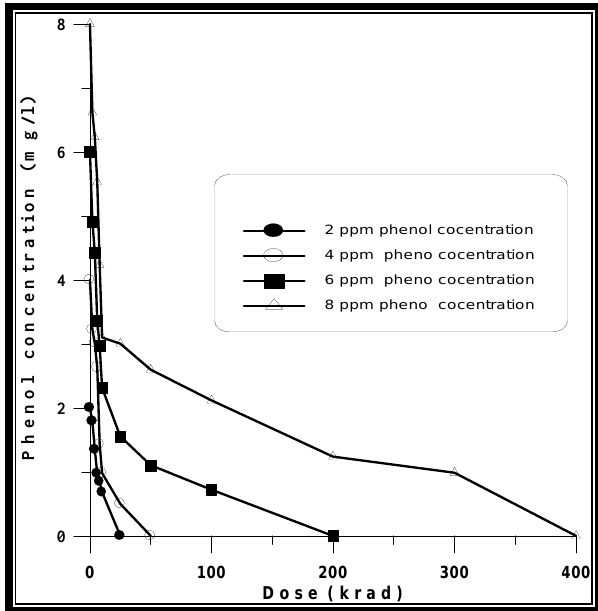
Figure 12: Phenol concentration values of standard solution of phenol with respect to radiation dose.